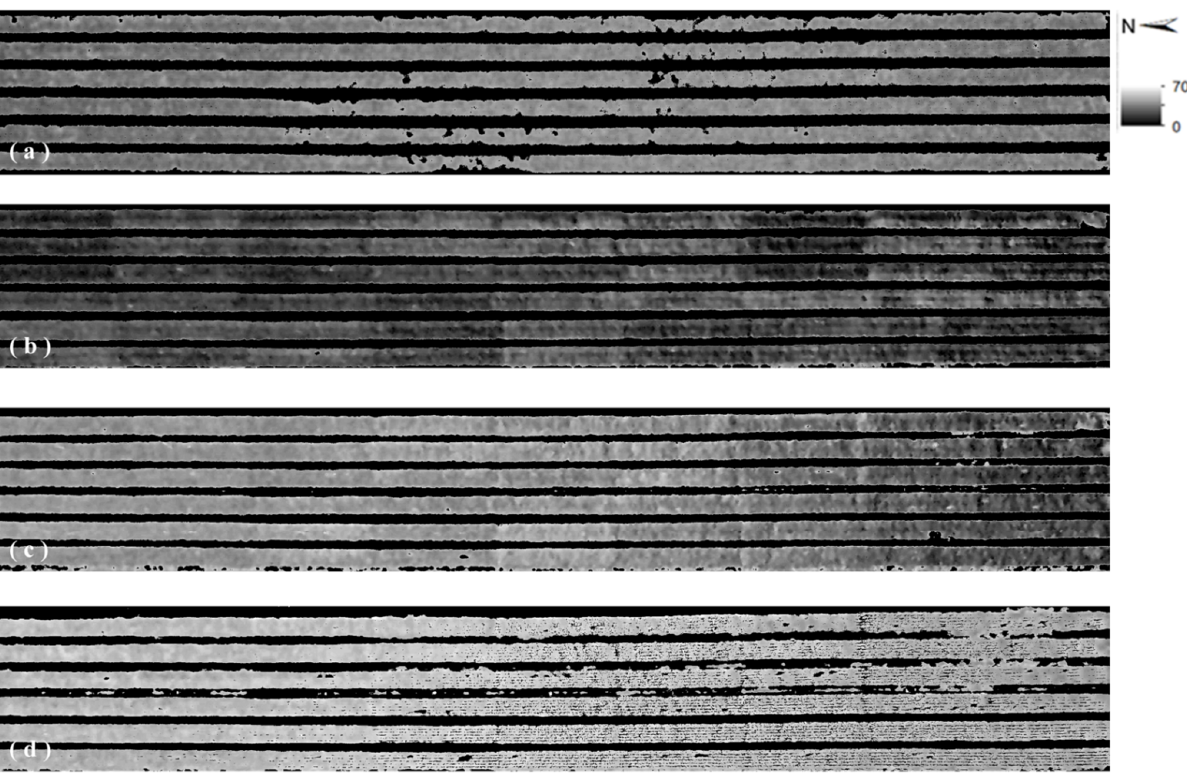
Figure 11. Estimated SPAD value images at 50.0 m by using the VI of ‘G-B’ on 8 December 2018 ( a ); 8 January 2019 ( b ); 5 5 February 2019 ( c ) and 14 March 2019 ( d February 2019 ( c ) and 14 March 2019 ( d ).